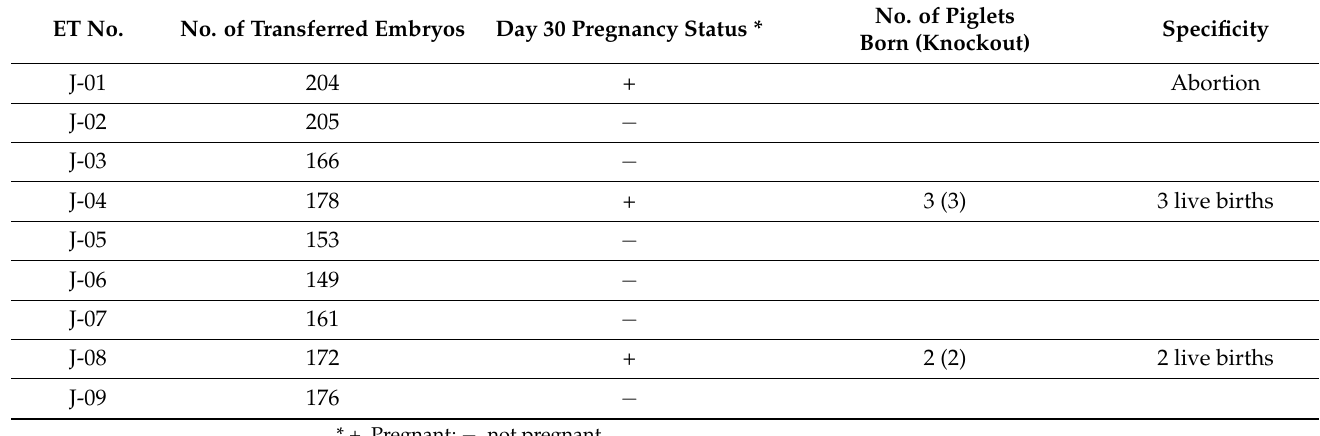
Table 4. Full-term development of triple-knockout piglets.